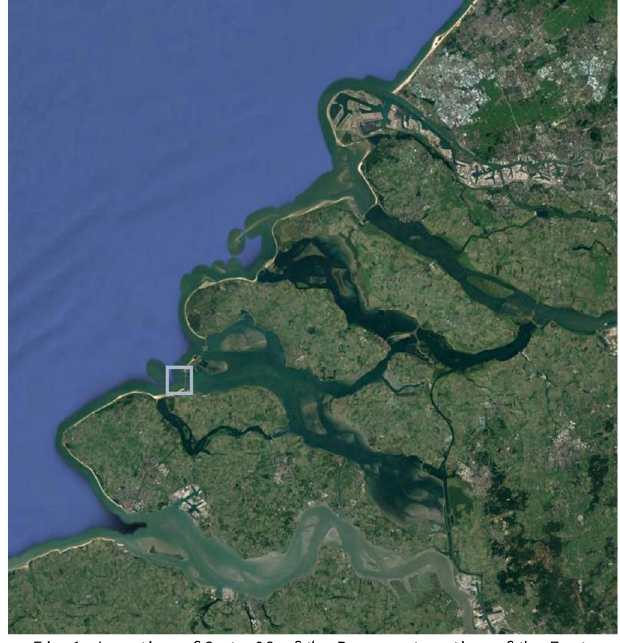
Fig. 1. Location of Gate+08 of the Roompot section of the Eastern Scheldt Barrier, shown on a satellite image (source: Google